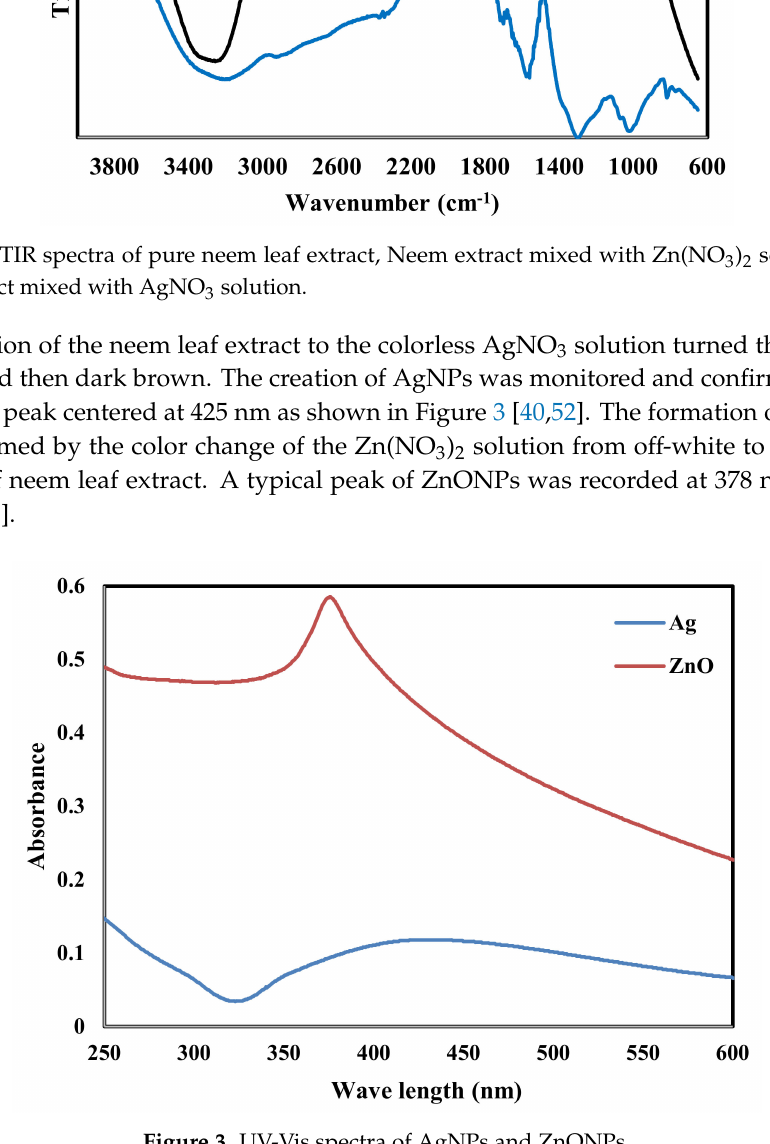
Figure 3. UV-Vis spectra of AgNPs and